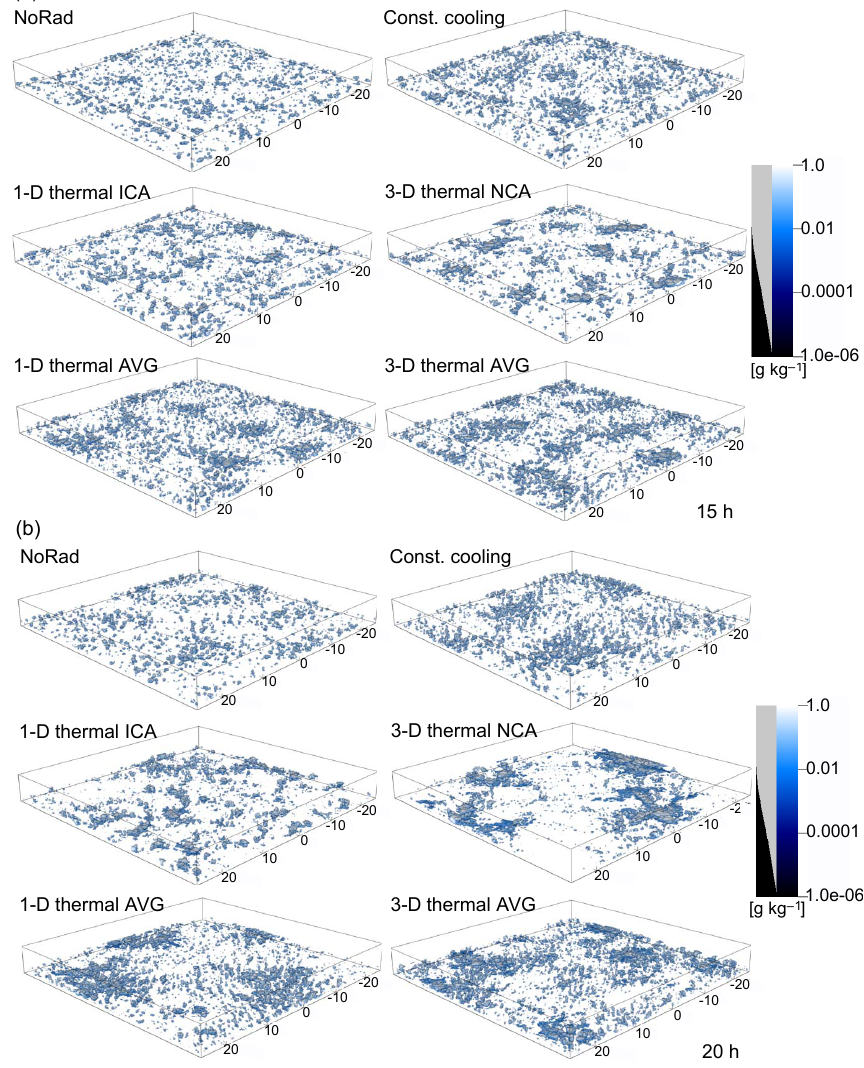
Figure 20. Cloud fields at 15h (a) and 20h (b) of the 100m resolution simulation. The quantity shown is liquid water mixing ratio. The black and gray bar shows the opacity used in this